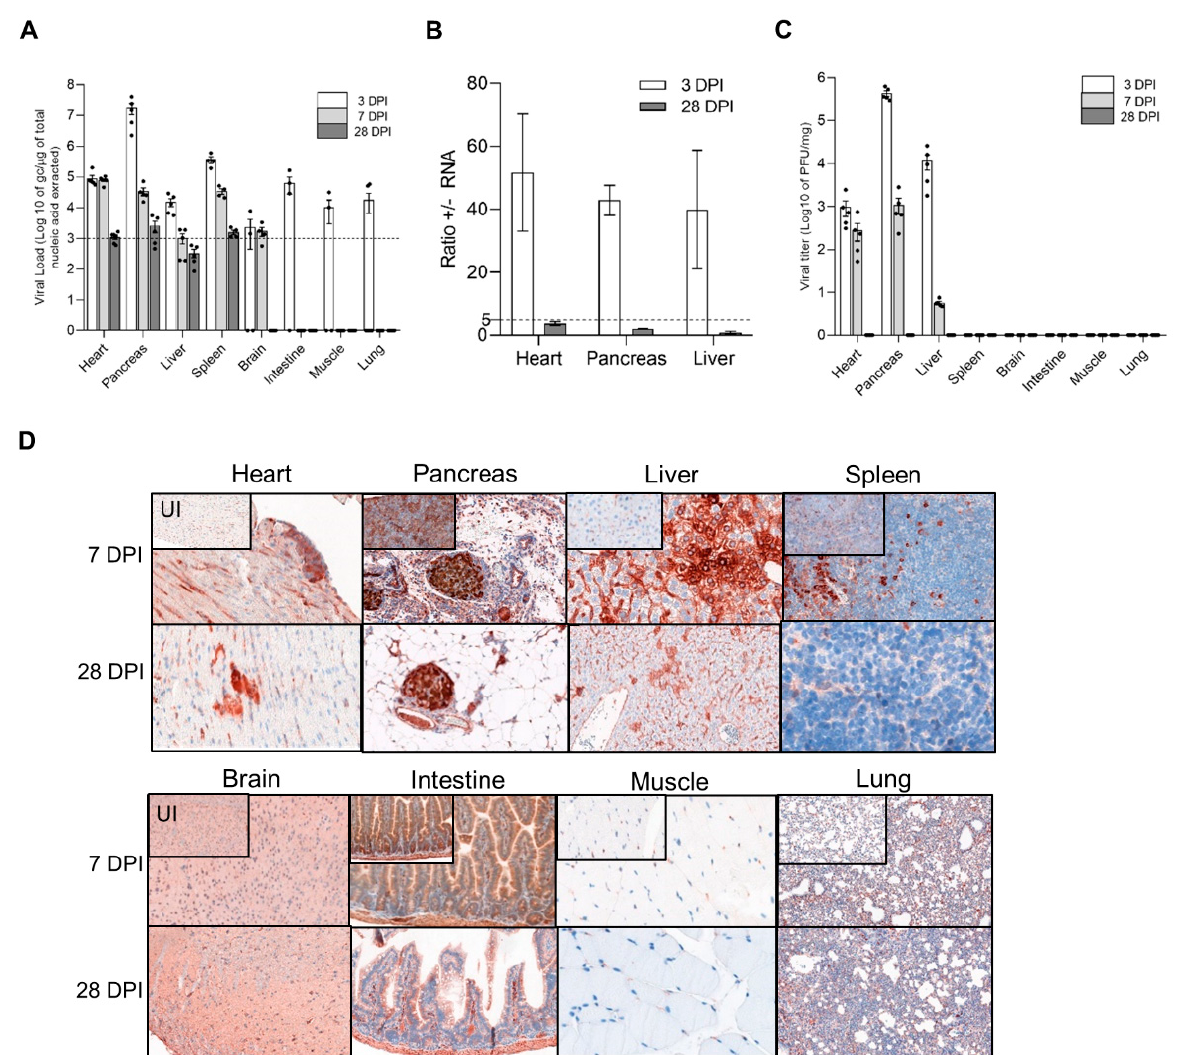
Figure 1. CVB3/28 replication and protein synthesis activities in DBA/2J mouse organs. ( A ) Viral loads were quantified in organs of CVB3/28-infected DBA/2J mice by classic RT-qPCR assay ( n = 6). Dotted line represents the significance threshold of 10 3 genome copy (gc)/microgram of nucleic acid extracted (Figure S1). Data represent mean +/ − standard error of the mean (SEM). ( B ) Positive to negative RNA ratio (+/ − RNA ratio) in the heart, pancreas, and liver at 3 and 28 DPI. Dotted line represents the threshold for viral persistence ( n = 3). ( C ) Viral titers were measured in organs of CVB3/28-infected DBA/2J mice by classic plaque forming unit assay ( n = 5). ( D ) VP1 was detected at 7 DPI and 28 DPI in cardiac cells, Langerhans islets cells, and hepatocytes. VP1 was found sparsely positive in the spleen at 7 DPI. Other organs were negative for VP1. Original magnification: 400 × . DPI: Days Post Infection. UI: Uninfected.